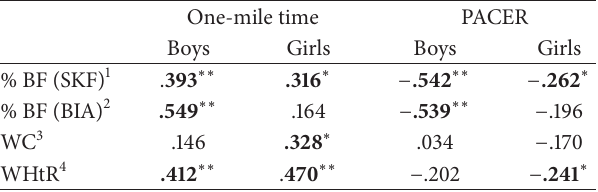
Table 6: Partial correlations controlling for BMI and age. One-mile time